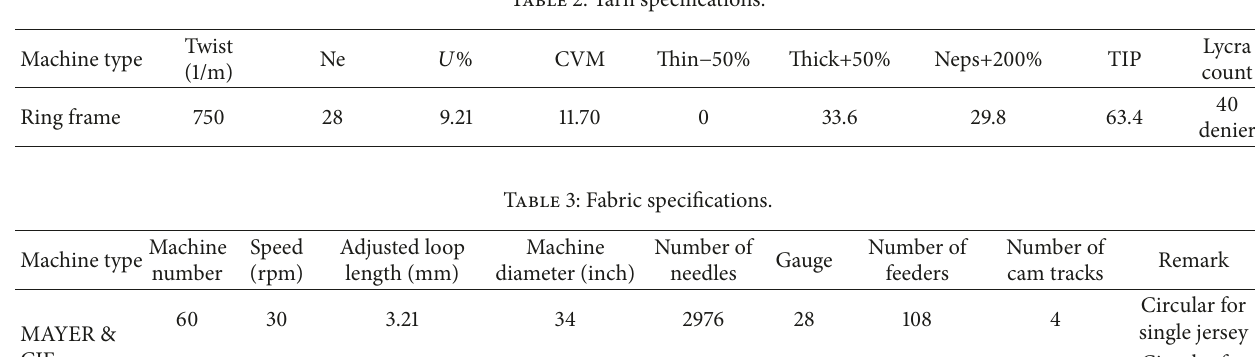
Table 2: Yarn specifications.